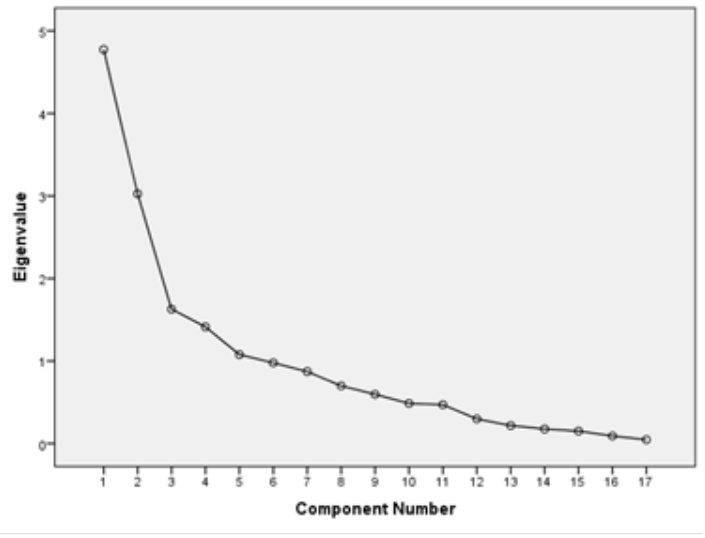
Pebble Test (Scree Test) on Peer Evaluation Checklist Factors